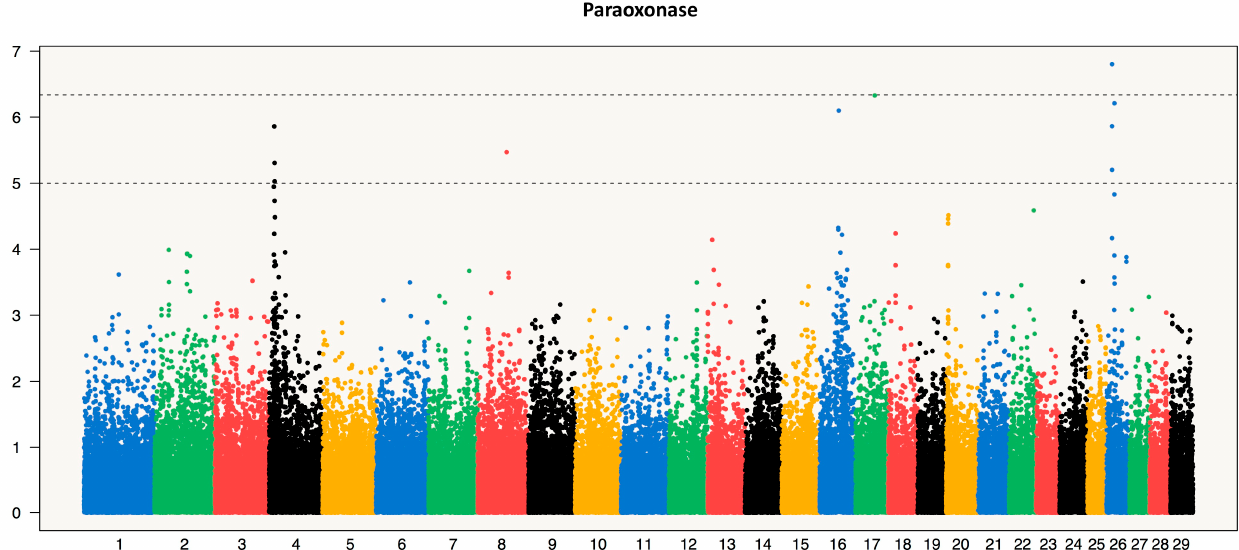
Figure 4. Manhattan plot of PON Genome-Wide Association Studies (GWAS) single-SNP meta-analysis. The upper horizontal dotted line is set at the nominal significant threshold values of p = 0.05 following Bonferroni correction for the number of SNP markers. The lower dotted line indicates the suggestive threshold value. The BTA4 peak corresponds to the PON1 gene. A significant peak is seen in BTA26 and a suggestive peak is seen in BTA16. An isolated significant SNP marker is seen in BTA17.